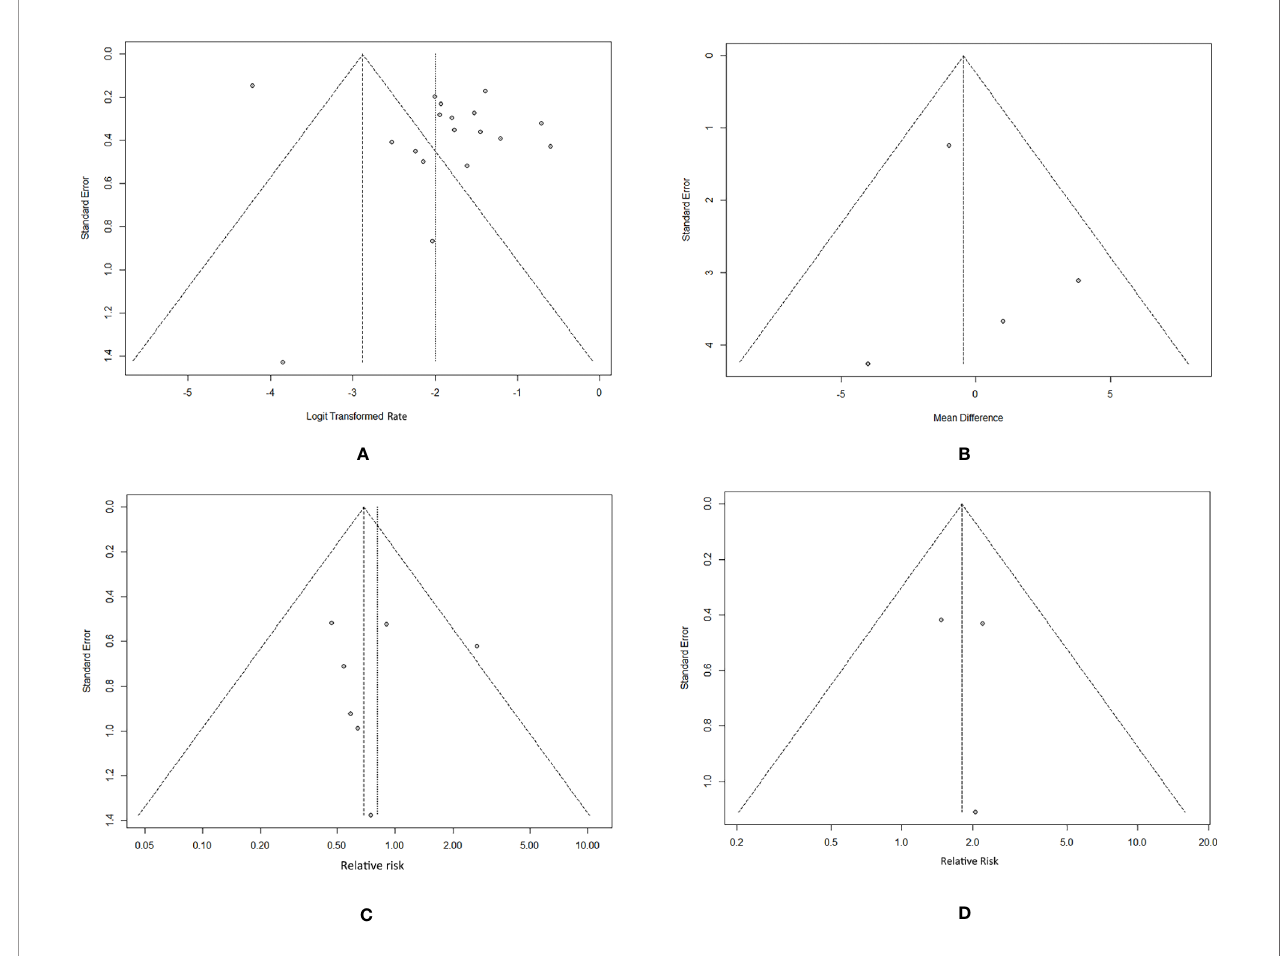
FIGURE 3 | Funnel plots of the SAT recurrence rate and risk factors. (A) recurrence rate. (B) age. (C) sex. (D) treatment